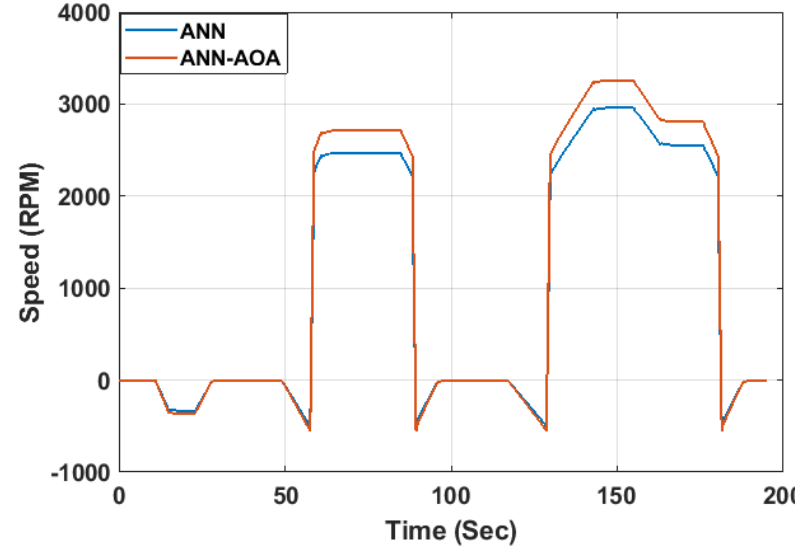
Figure 14. Analysis of motor speed with ANN and ANN–AOA.